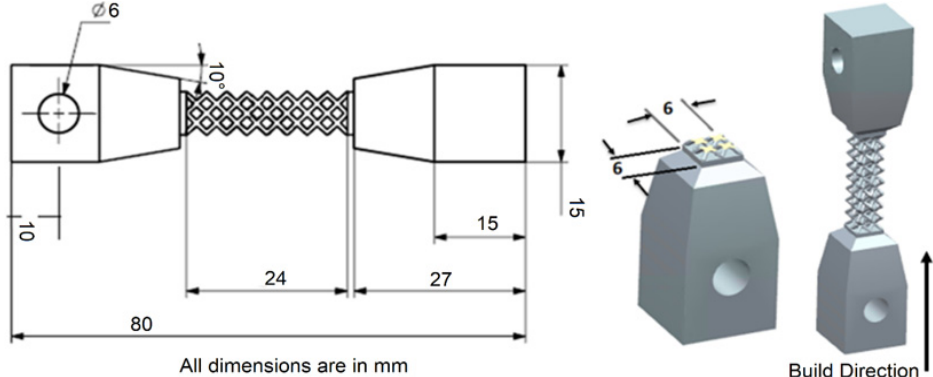
Figure 8. CAD representation and dimensions of tensile test specimen